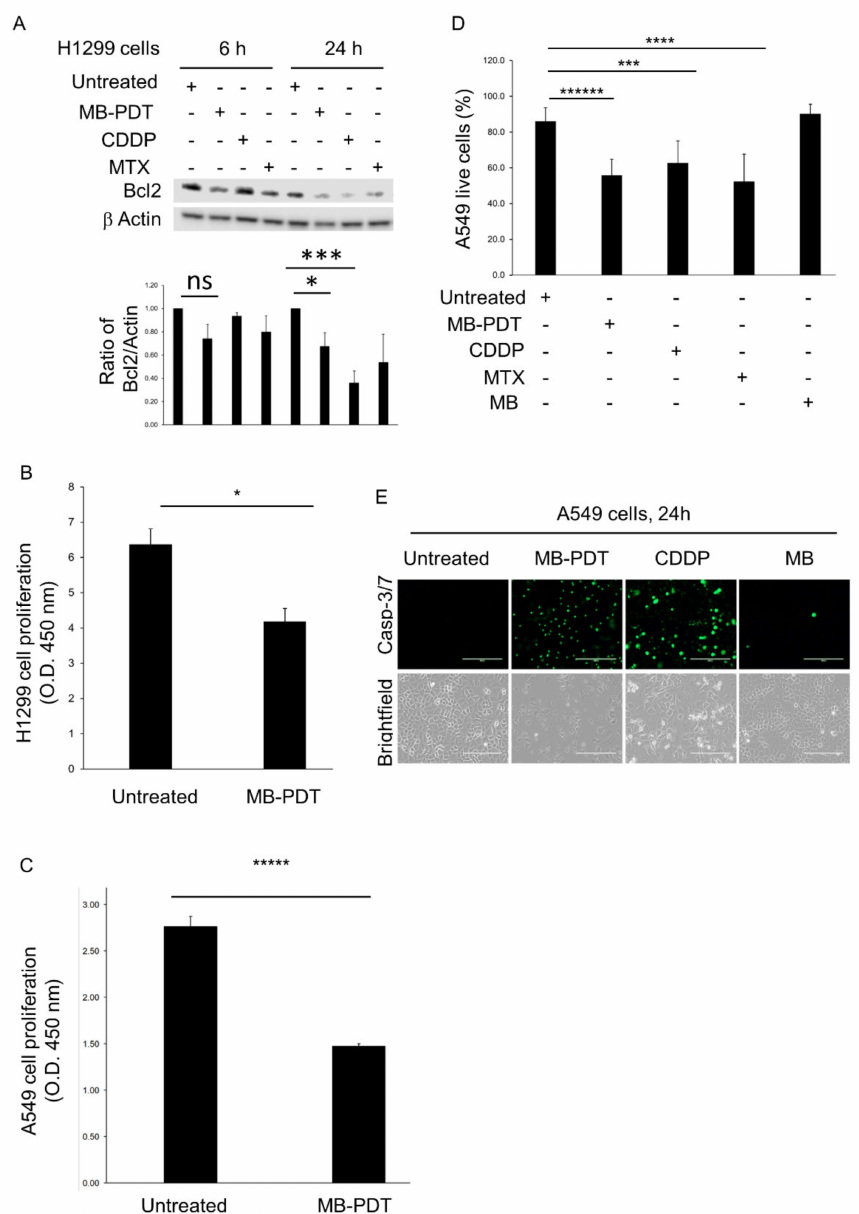
Figure 1. MB-PDT-treated lung cancer cells undergo apoptosis and show reduced proliferation. ( A ) Representative immunoblotting of Bcl2 expression in MB-PDT-treated (20 µ M) H1299 cells for 6 and 24 h. Densitometry of three Western blots is presented below. * p = 0.03, *** p = 0.002. ( B ) The proliferation of H1299 cells was analysed by WST-1 assay 24 h post-treatment. The absorbance was obtained by a Synergy H1 Hybrid Reader at 450 nm. Data included 3 independent experiments, n = 9 (per condition), * p < 0.05. ( C ) The proliferation of A549 cells was analysed by WST-1 assay 24 h post-treatment. Data included 3 independent experiments, n = 8 (per condition). ***** p = 0.00001. ( D ) A549 cells were treated with MB-PDT (20 µ M). CDDP (20 µ M) was used as an inducer of apoptosis, and MXT (1 µ M) was used to induce ICD. 20 µ M MB without PDT was used as an internal control. Viable cells were determined by trypan blue after 24 h post-treatment. The data are expressed as the mean ± SEM. Data included 2 independent experiments, n = 8 (per condition). **** p < 0.0078, ****** p = 0.000004. ( E ) Representative immunofluorescence images of caspase 3/7 probe activity in A549 cells 24 h post-treatment. 20 µ M MB without PDT was used as an internal control. Images taken using an Evos 2 microscope. Scale bar: 200 µ